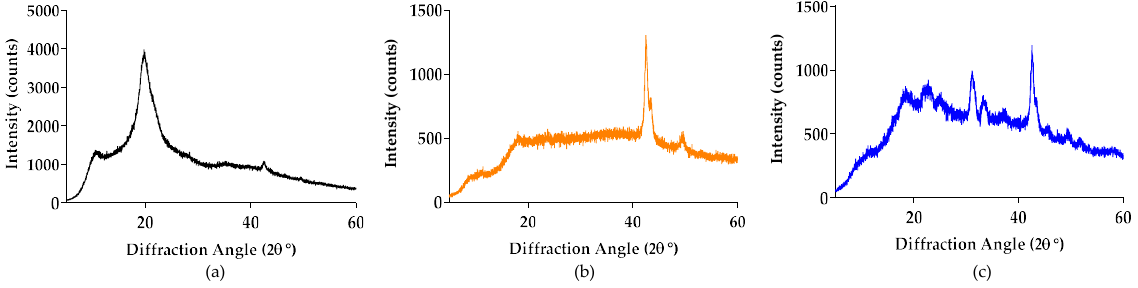
Figure 2. X-ray diffraction patterns of ( a ) chitosan, ( b ) glutaraldehyde-activated chitosan nanopar- ticles, and ( c ) endo-1,4-β-mannanase immobilised on glutaraldehyde-activated chitosan nanoparti- cles.